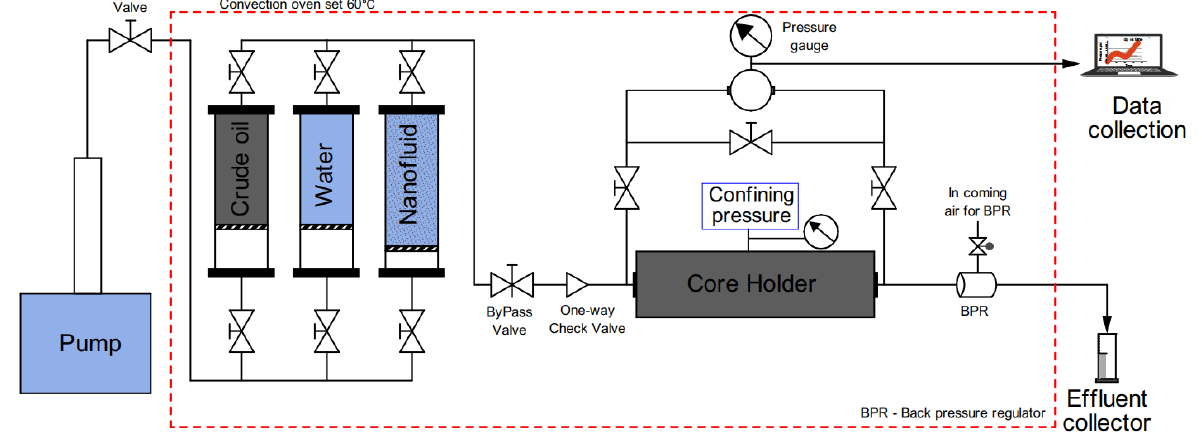
Figure 3. Schematic diagram of core flooding